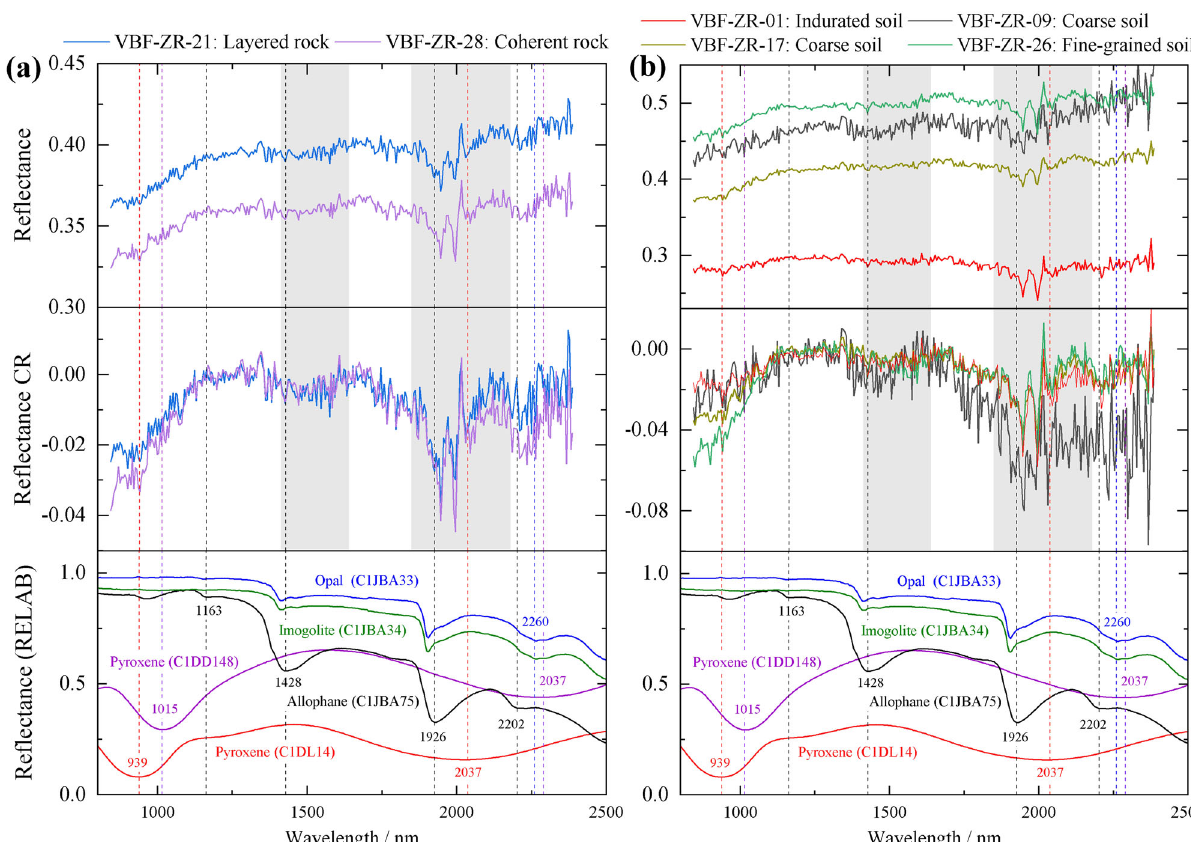
Fig. 2 Absolute SWIR spectra and mineral identi fi cation. The SWIR spectra before and after continuum removal (CR) of selected VBF-ZR rocks ( a ) and soils ( b ) compared to the spectra of pyroxene, imogolite, allophane, and opal from RELAB database. Dotted lines indicate the absorption centers of these phases. The gray regions indicate absorption features of the Martian